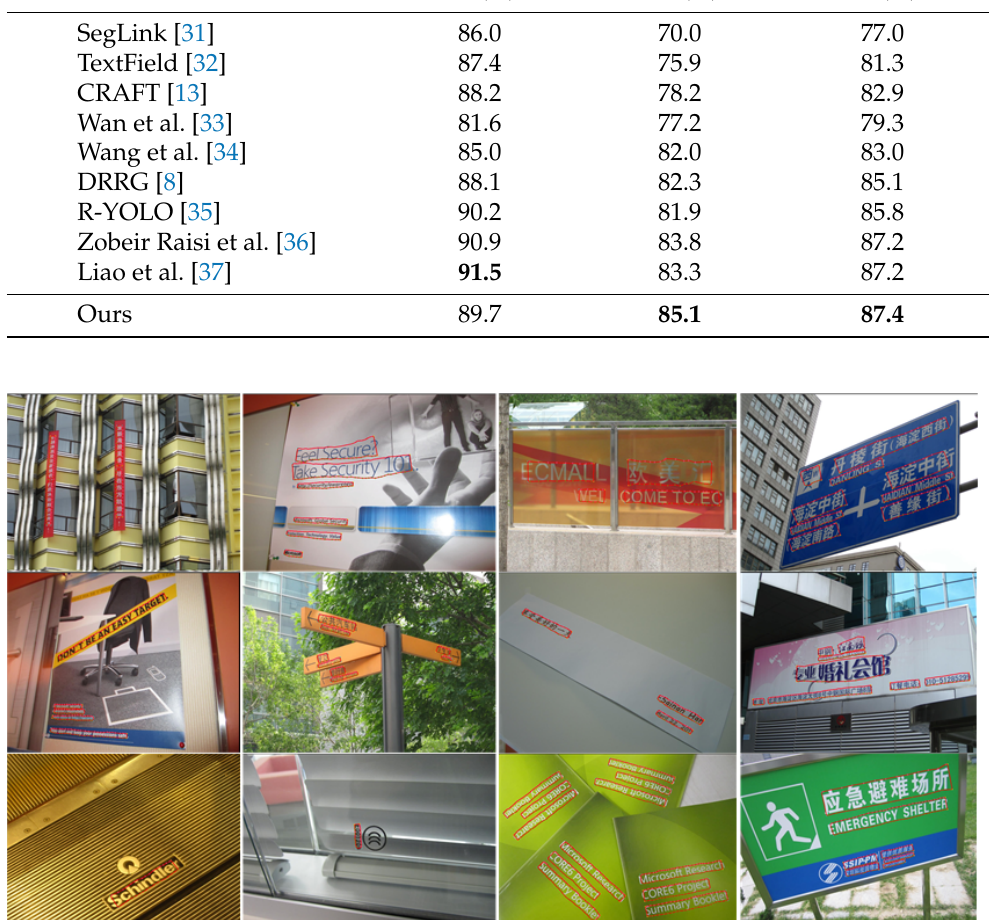
Figure 9. Detection examples obtained by the proposed method on the MSRA-TD500 dataset. Experiments on CTW-1500 dataset. In addition, to verify the robustness of our method in terms of detecting irregular scene text, we also select the CTW-1500